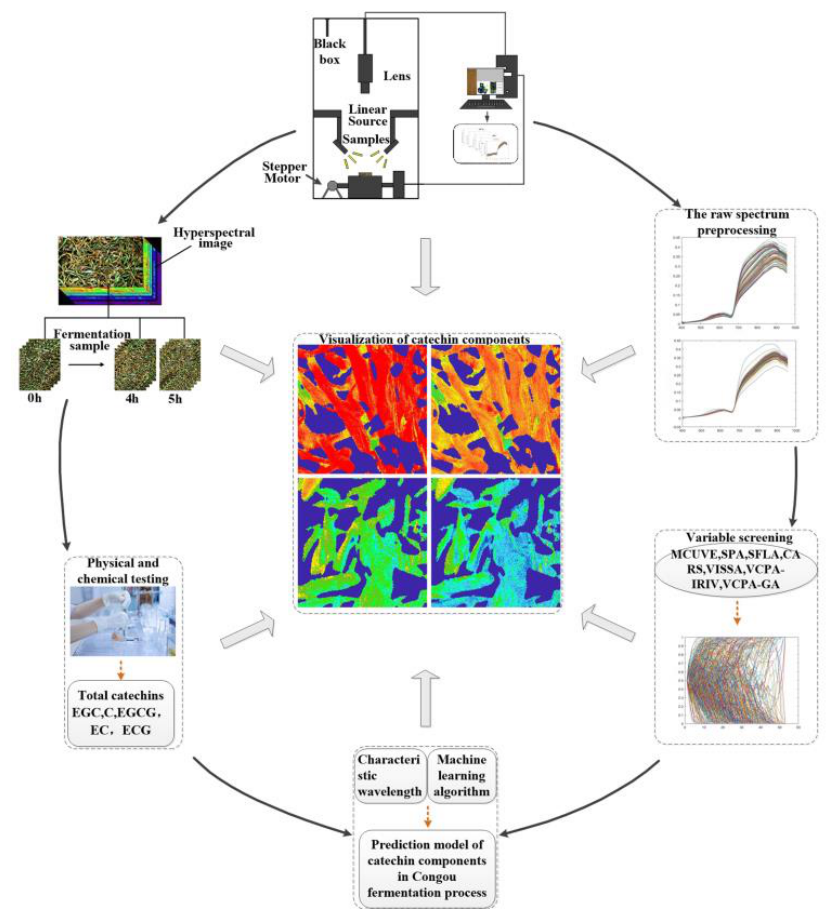
Figure 1. Hyperspectral data acquisition system flowchart. During data acquisition, the samples were evenly placed in a 17 cm × 8 cm rectangular glass frame with the surface of the tea leaves flush with the top of the glass frame.